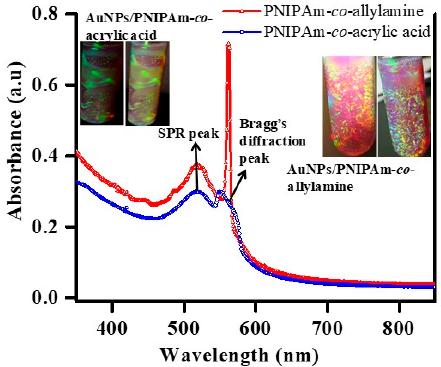
Figure 2. UV/VIS absorption spectra of hybrid poly( N -isopropylacrylamide) (PNIPAm) colloidal microgel crystals. The absorption spectra show the characteristic surface plasmon resonance (SPR) of spherical AuNPs and Bragg’s diffraction peak of orderly arranged PNIPAm colloidal crystals.